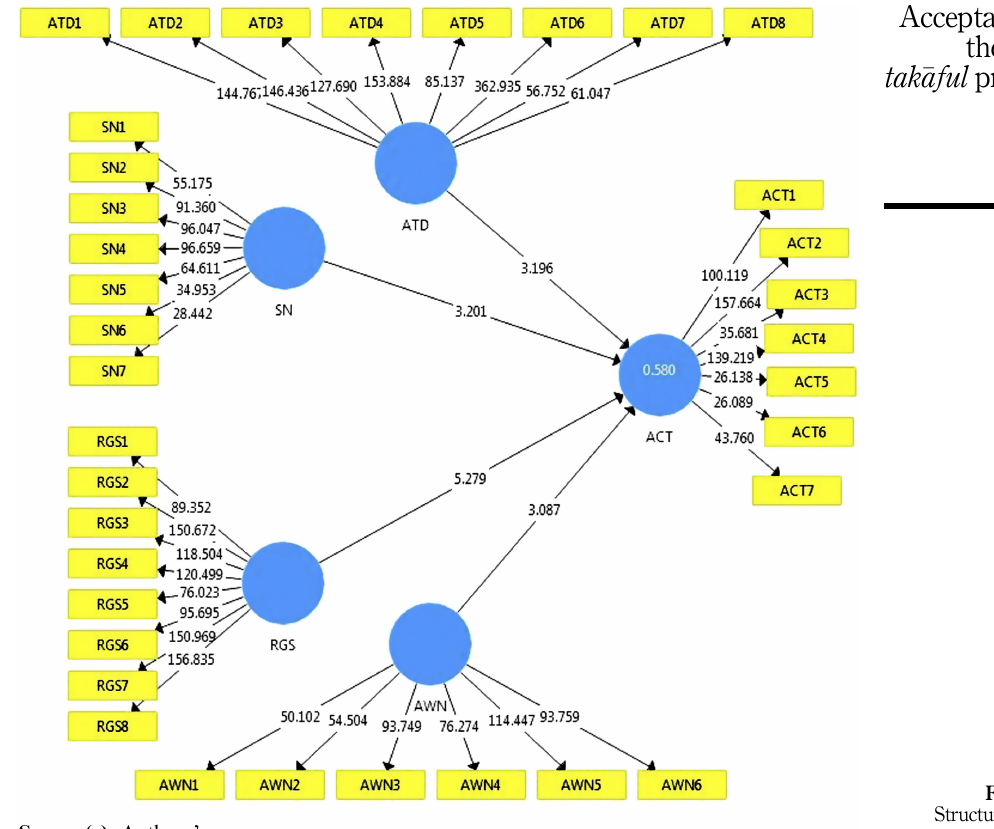
Figure 1. Structural